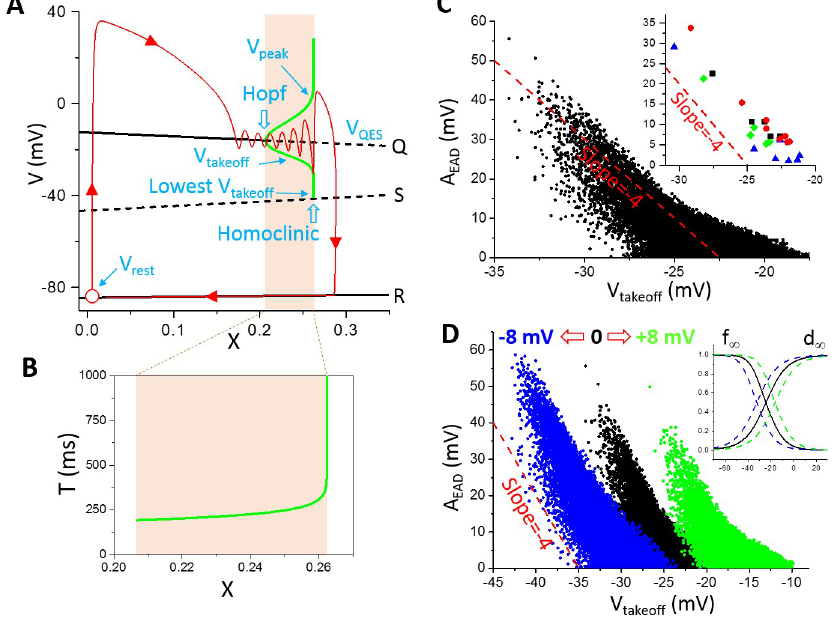
Fig 2. Bifurcation and EAD amplitude in the LR1 model. A . Bifurcations in the fast subsystem when treating the slow subsystem (X) as a parameter. Q, S, and R are the three equilibria in the fast subsystem. The green bell-shaped envelope is the steady state oscillation amplitude (from V takeoff to V peak ) from the Hopf bifurcation point to the homoclinic bifurcation point. The lowest possible takeoff potential is at the homoclinic bifurcation point, which is around -41.5 mV. The red trace (arrows indicate the time course) is an AP from the whole system where X is a variable. Open red circle is the resting state. Note: the bifurcations and simulations shown in this panel and panel B were done without the presence of I Na . B . The steady-state oscillation period from the Hopf bifurcation point to the homoclinic bifurcation point. C . A EAD versus V takeoff . The parameters were randomly drawn from the assigned intervals as described in Methods. For each parameter set, the amplitudes of all EADs in the AP were included. The inset shows representative A EAD versus V takeoff from individual APs distinguished by colors. D . Same as C but for shifted I si kinetics (d 1 and f 1 ). The green data points are for d 1 and f 1 shifted 8 mV toward more negative voltages and the blue ones are for d 1 and f 1 shifted 8 mV toward more positive voltages. The inset shows the corresponding shifts. Panels A and B were replots from Tran et al [12]. The dashed straight lines in C and D are references for slopes.